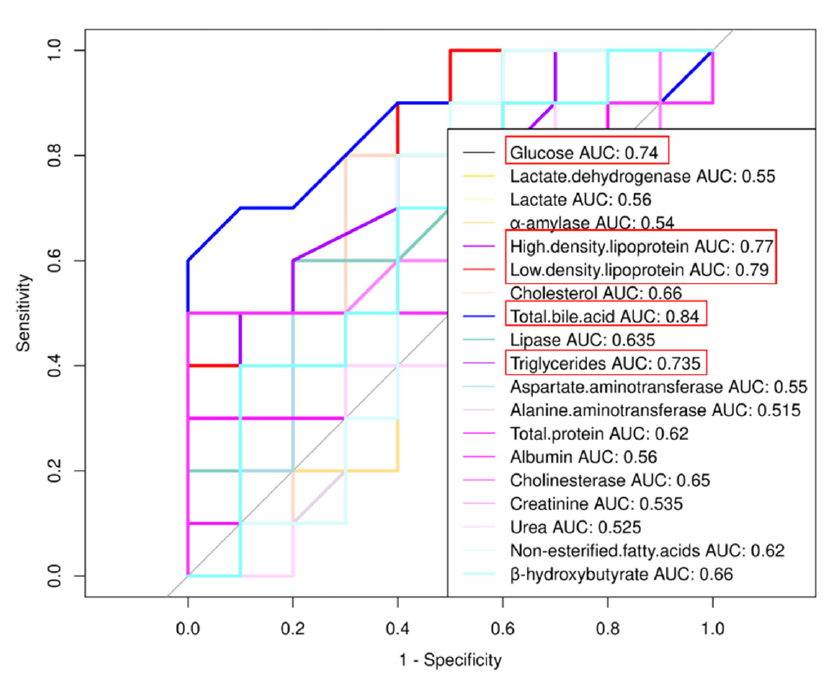
Figure 1. Receiver operating characteristic (ROC) curve analysis of biochemical indexes. If the area under the curve (AUC) is greater than 0.70, parameters are considered correlation.